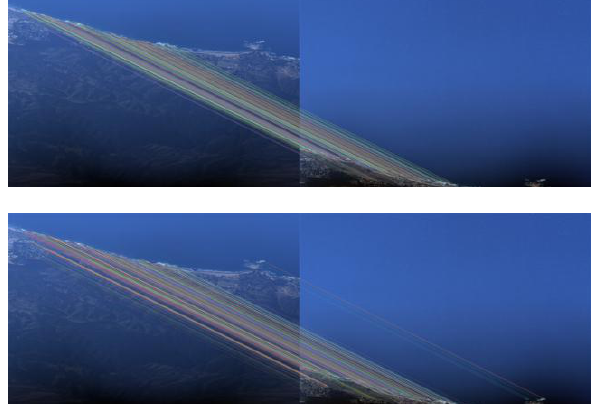
Figure 6: Matches using standard RANSAC (top) vs. matches using variation on RANSAC that prefers even spatial distribution (bottom). Note the linear cluster of tie-points in top, and additional tie-points outside the cluster